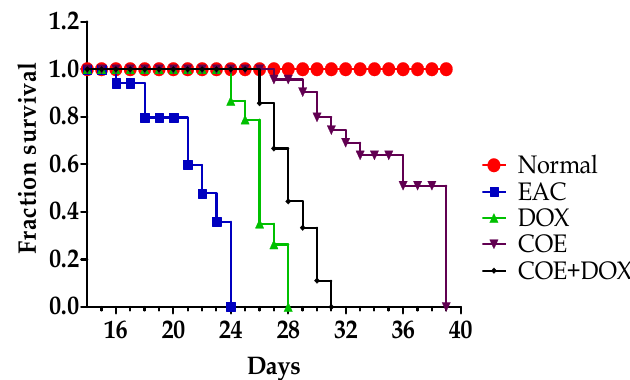
Figure 1. Effect of COE on survival time in EAC mice.